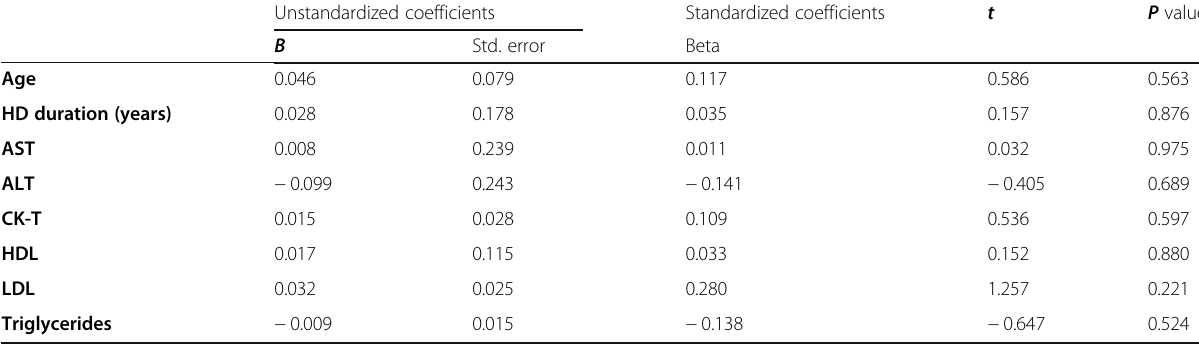
Table 4 Linear regression analysis displaying independent predictors of IL-6 at baseline